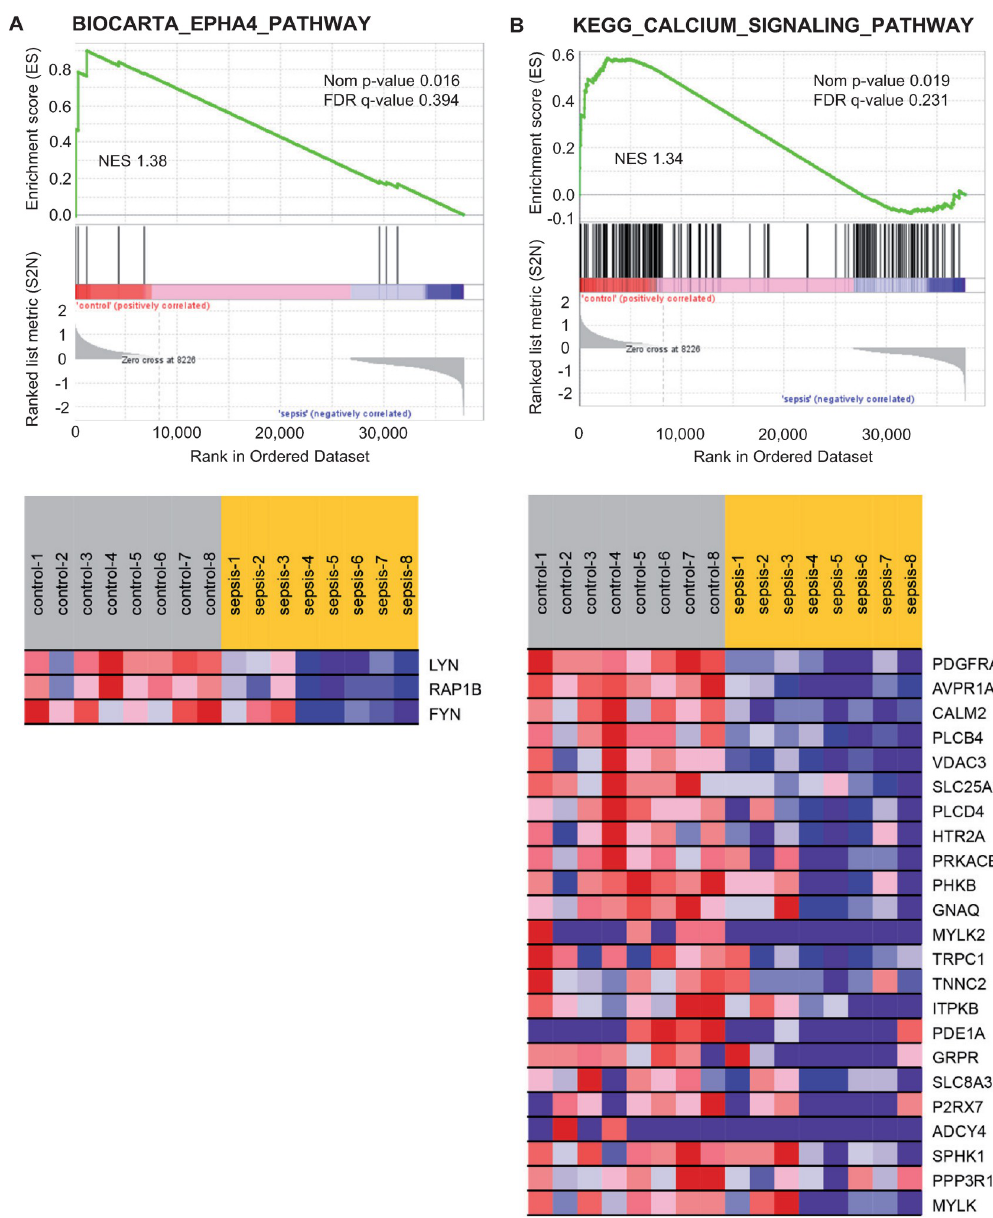
Fig 7. Gene Set Enrichment Analysis with predefined gene sets related to platelet activation identifies two gene sets enriched in the platelet transcriptome from patients with sepsis compared to control patients. Shown are results for BIOCARTA_EPHA4_PATHWAY (A) and KEGG_CALCIUM_SIGNALLING_PATHWAY (B), two of 29 analysed gene sets (S1 Table) enriched in platelets from patients with sepsis, at a nominal (Nom) p value of < 0.05 and normalised enrichment scores (NES) of > 1.3. The normalised enrichment score represents the primary metric since it allows comparison between gene sets by taking the gene set size and correlations between the expression data and the gene sets into account [24]. Genes within the core enrichment (dark red in ranked list metric) are depicted with respective expression values as heatmap below. Core enrichment comprises the leading edge subset of genes that add most to the enrichment score, being ranked at the top of the gene set before a positive peak enrichment score (maximal value of green line)